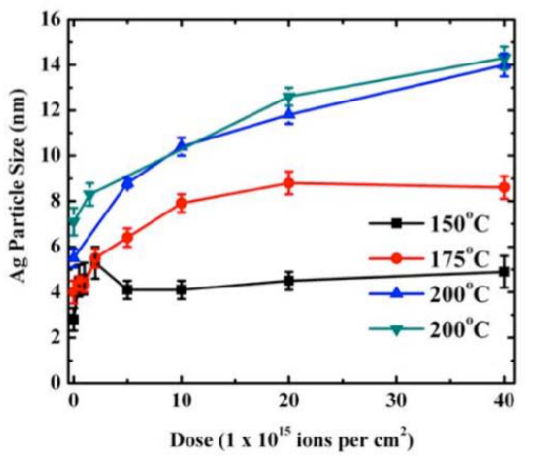
Fig. 2: Z-contrast TEM image of nanostructured Cu-Nb-W alloy with high resistance to thermal coarsening at